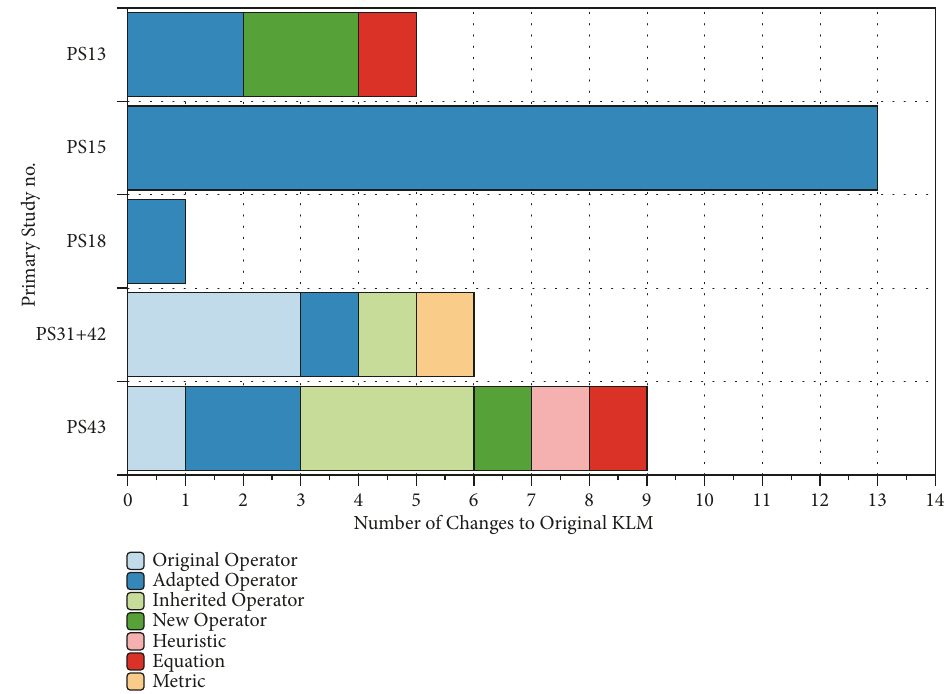
Figure 11: The number of original operators preserved, adapted, inherited from other extension or literature, and newly introduced in the traditional IVIS setup